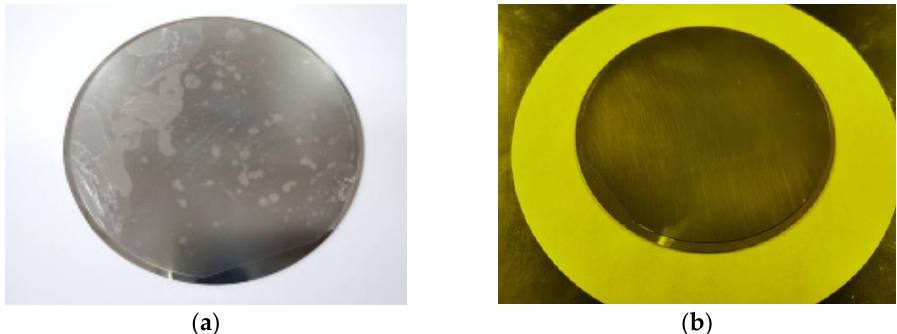
Figure 4. Results of photoresist coating at different temperatures: ( a ) laboratory temperature; ( b ) 60 °C. Table 3. Settings for baking before